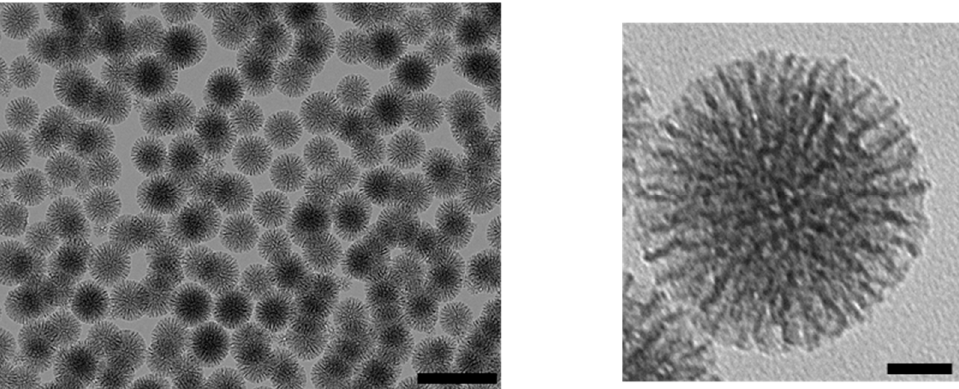
Figure 1. TEM image of large-pore mesoporous silica nanoparticles (LPMSNs). Scale Bar 200 nm ( left ) and 50 nm ( right ), respectively.